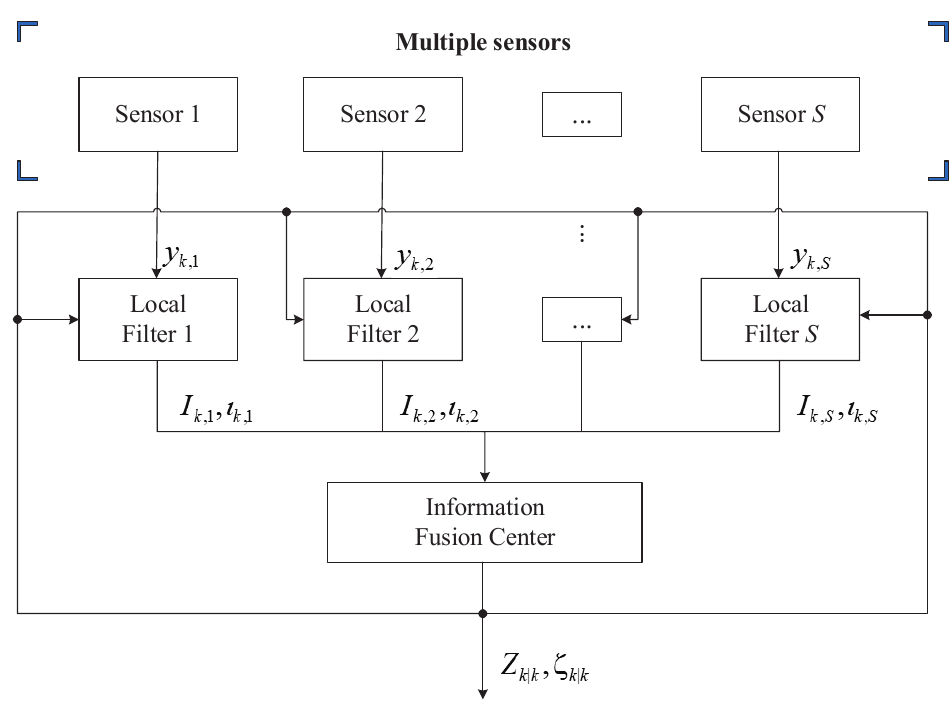
Figure 1. Multi-sensor information feedback